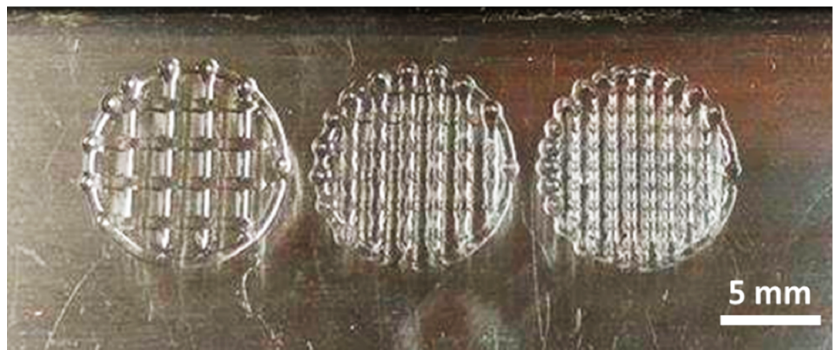
Figure 6. Grid structure ( single layer ) of pluronic F127 by using 21G nozzle at 1 × 10 5 Pa and 0 . 025 m / s speed ( scale bar = 5 mm ) .